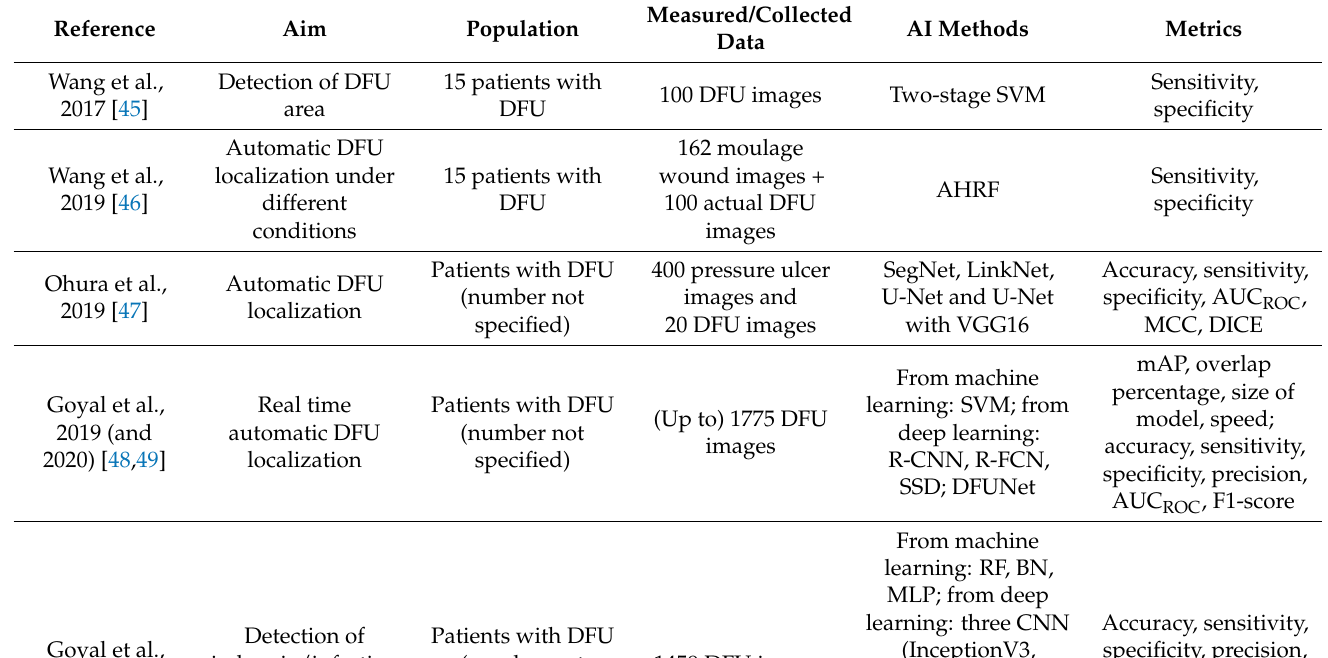
Table 4. Summary information related to the studies about overt diabetic foot ulcers—studies based on imaging. List of abbreviations is reported in the Abbreviations